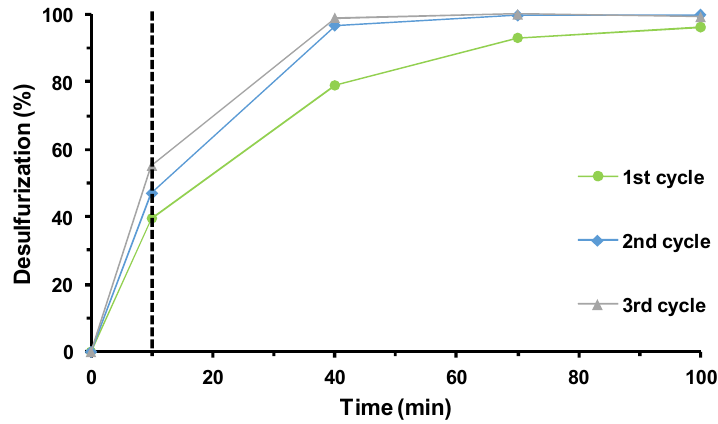
Figure 7. Kinetic desulfurization profiles of multicomponent model diesel catalyzed by PW 12 @TM–SBA-15 for three continuous recycling cycles using ionic liquid ([BMIM]PF 6 ) as an extraction solvent at 70 °C.